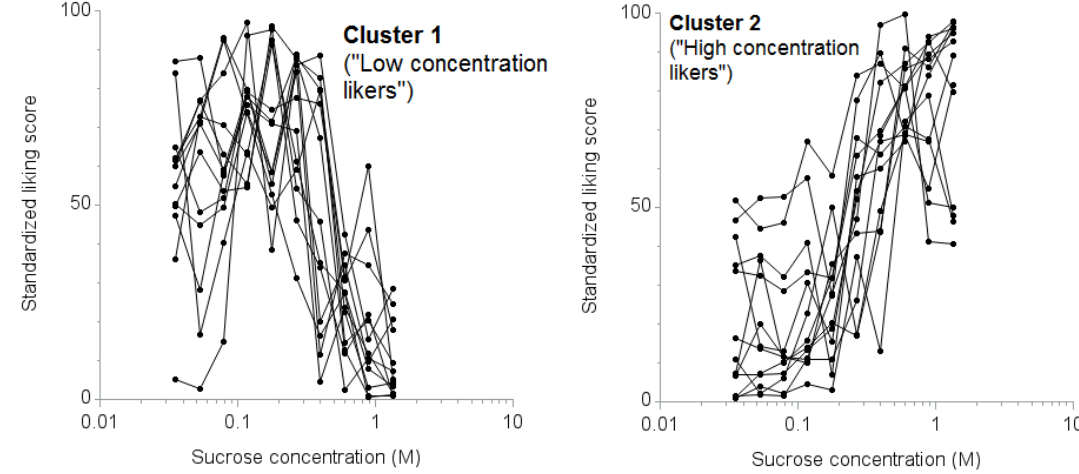
Figure 1. Intraclass correlation coefficients (95% confidence interval) for two repeated measurements of liking scores by sucrose concentration.